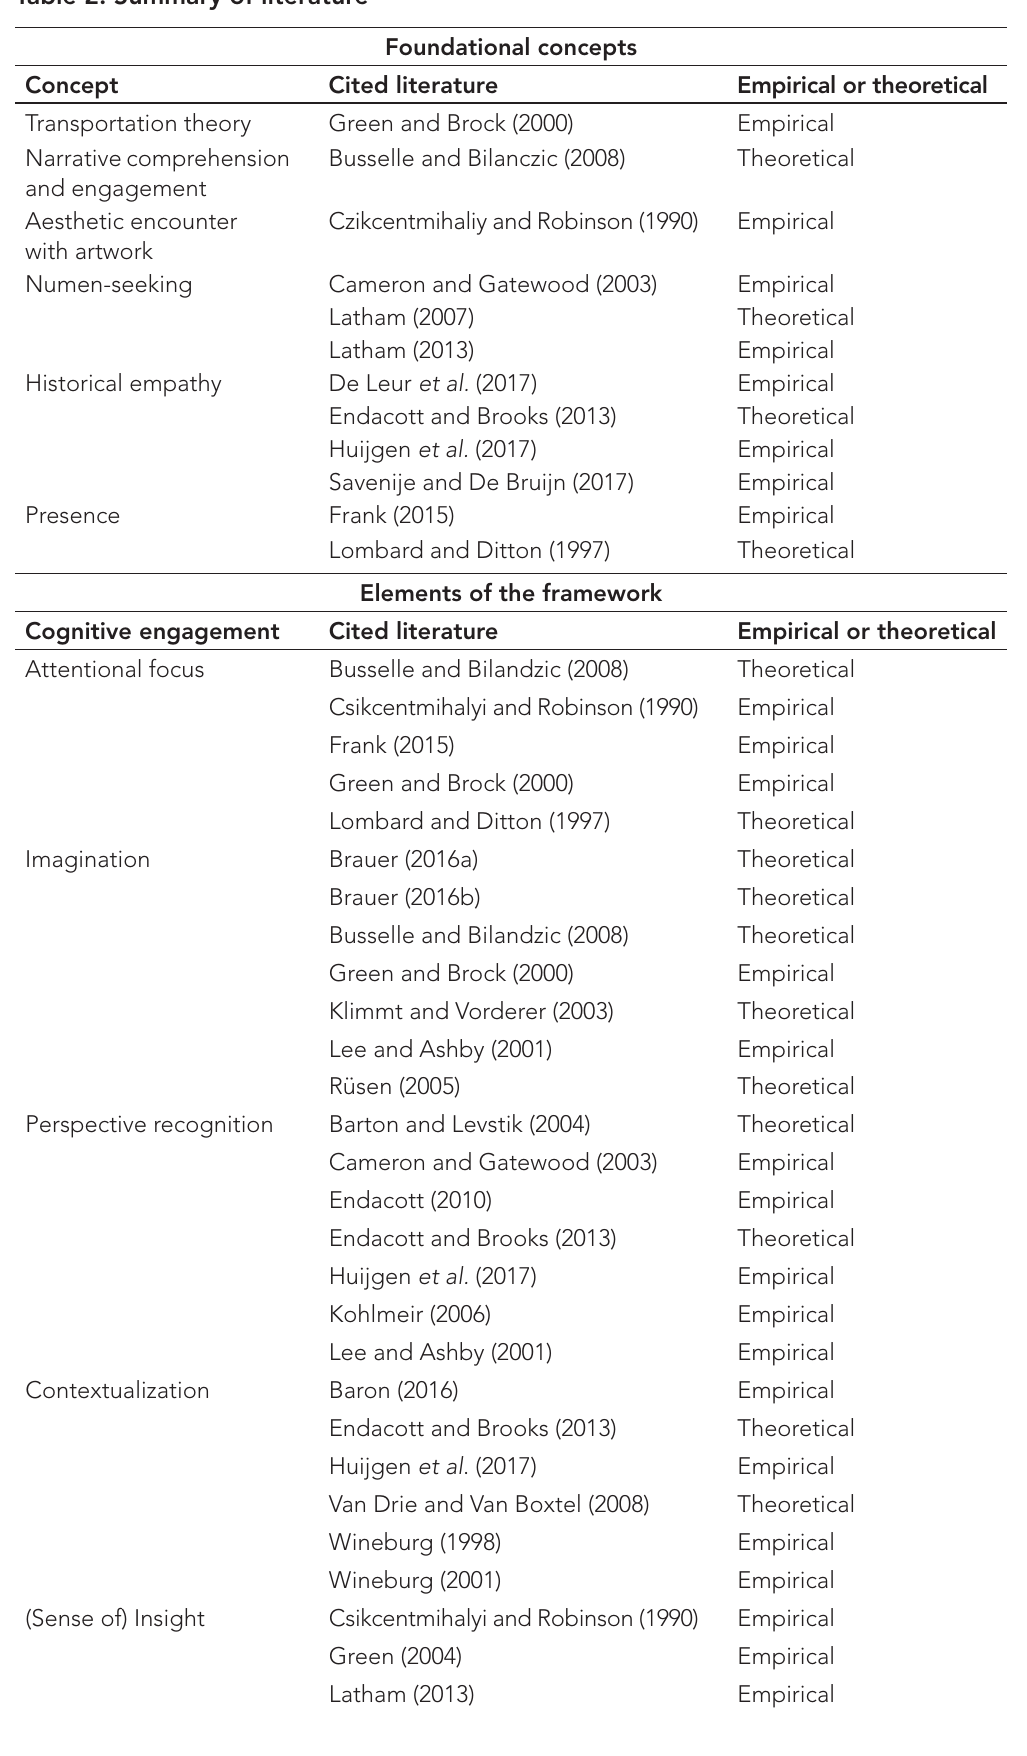
Table 2: Summary of literature